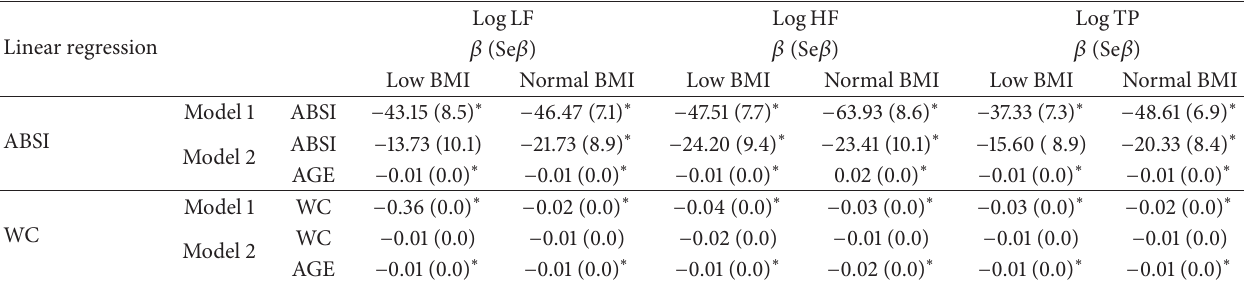
Table 2: Linear regression models describing the associations between HRV indices versus ABSI and WC in normal BMI and low BMI study